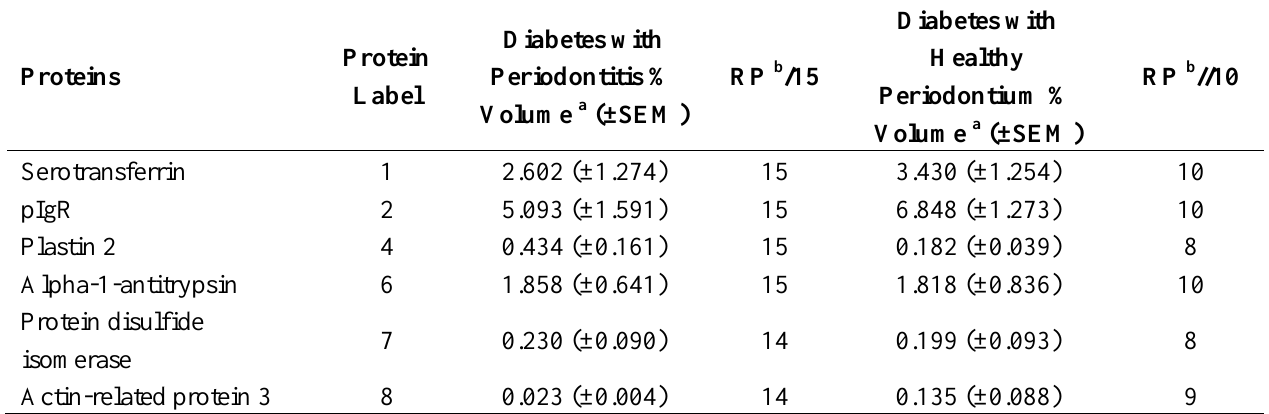
Table 1. Densitometry analysis of saliva proteins and their rates of presence in protein